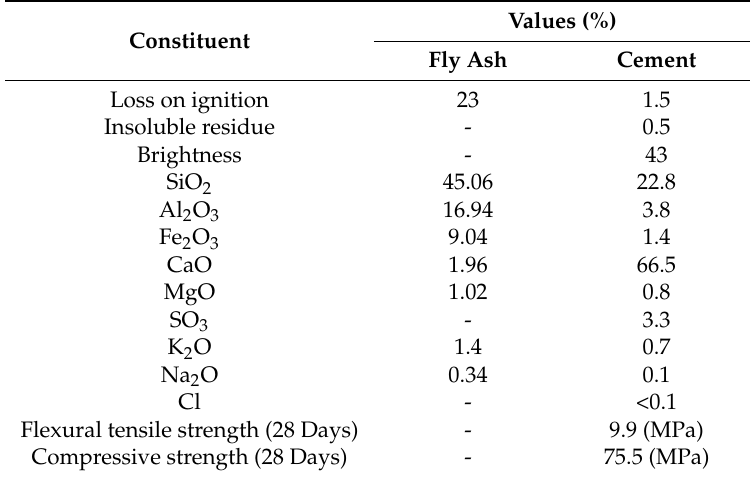
Table 1. Chemical characteristics of Portland cement and FA.